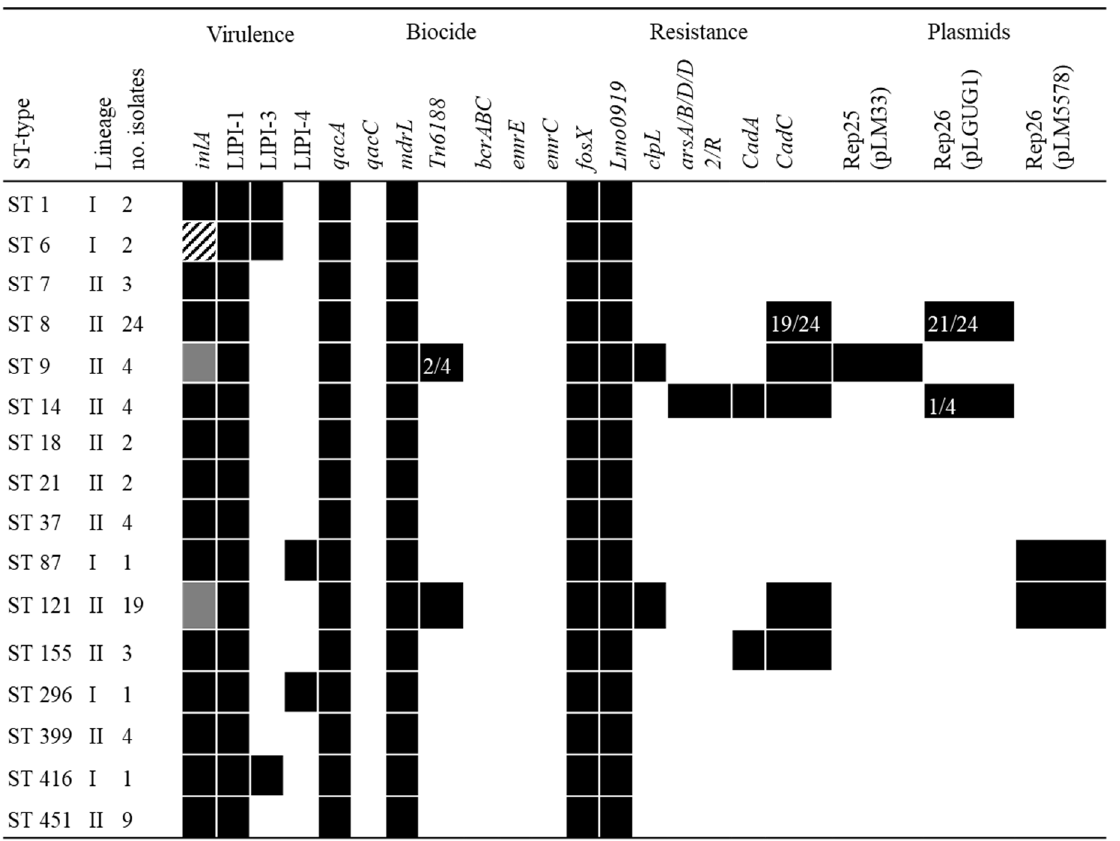
Figure 4. Presence of selected elements and genes associated with virulence, biocide and antibiotic resistance and plasmids in the isolates belong to the different STs. Gray cells in internalin A ( inlA ) indicate presence of premature stop codons and diagonal shading indicates inconclusive result. The numbers in cells indicate the number of isolates which contained the genes out of the total number of isolates.